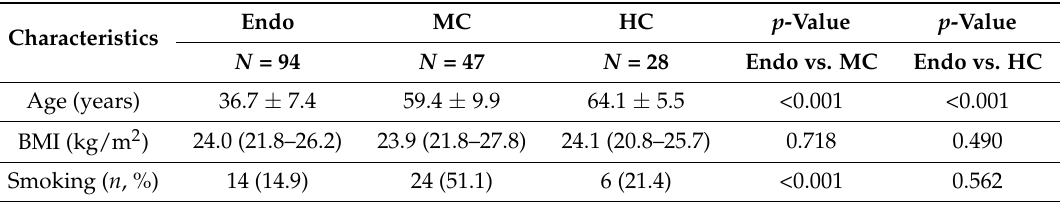
Table 1. Patient and control group characteristics in endometriosis and controls included in the proximity extension assay